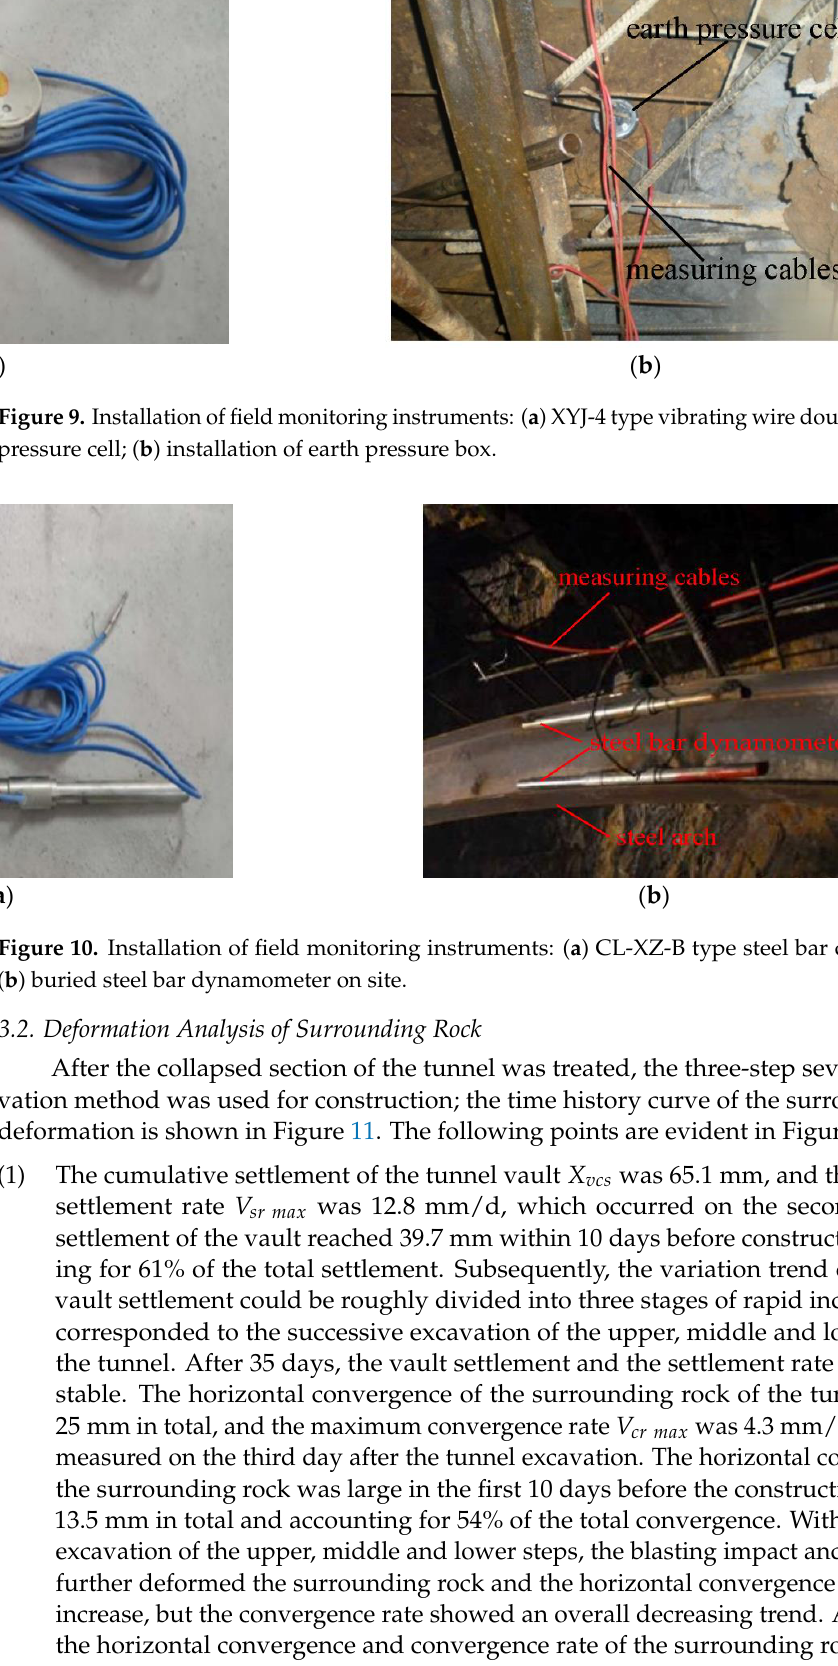
Figure 9. Installation of field monitoring instruments: ( a ) XYJ-4 type vibrating wire double dia- phragm pressure cell; ( b ) installation of earth pressure box.